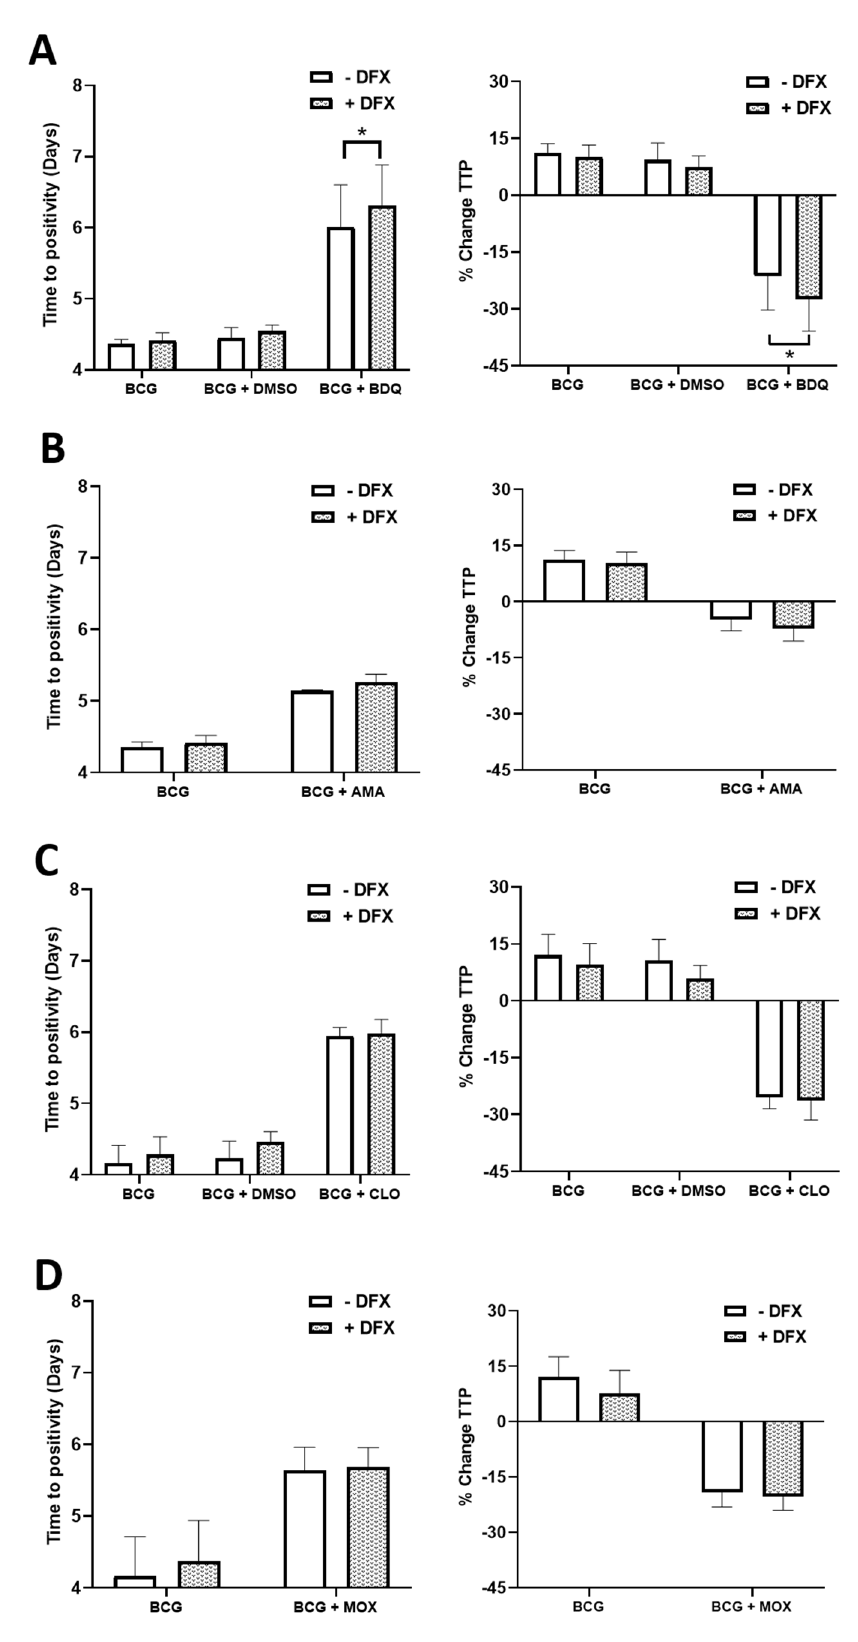
Figure 2. Examining if DFX can increase the efficacy of moxifloxacin, bedaquiline, amikacin and clofazimine in hMDMs infected with BCG. hMDMs, obtained from healthy blood donors, were